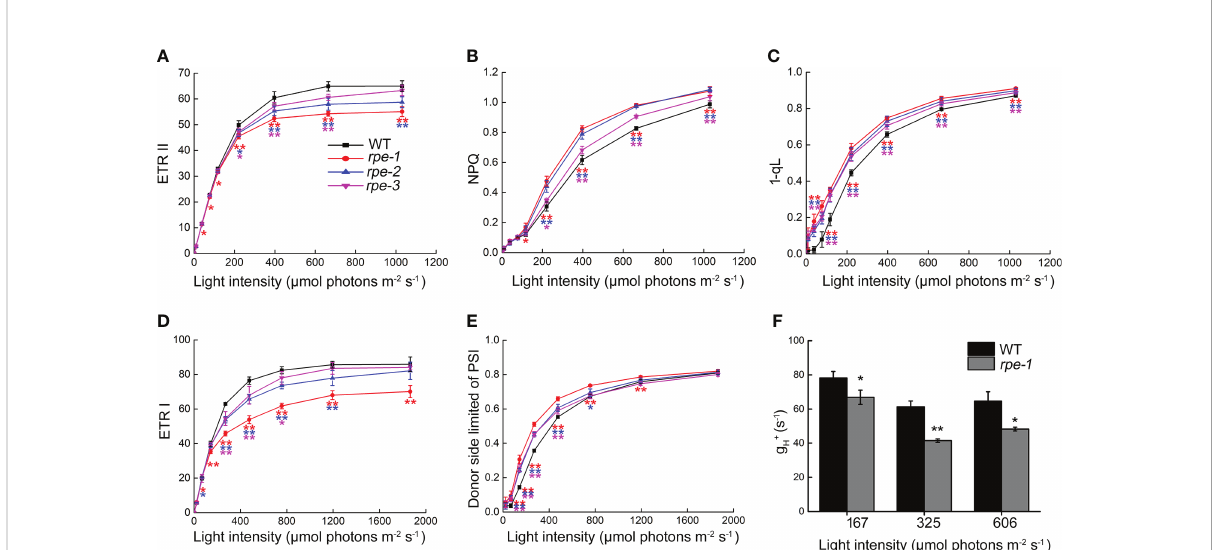
FIGURE 6 Analysis of light intensity dependence of photosynthetic parameters of WT and the rpe mutants. (A) Electron transport rate around PSII (ETR II). (B) Nonphotochemical quenching (NPQ). (C) 1-qL of PSII. qL means the fraction of open PSII centers, and 1-qL re fl ects the PQ redox state of PSII. (D) Electron transport rate around PSI (ETR I). (E) Donor-side limited PSI (with donor-side oxidized). (F) Analysis of ATP synthase activity in WT and rpe-1 . Values are means ± SD (n=3-6).Signi fi cant differences between WT and the rpe mutants are indicated by asterisk according to the Student ’ s t test (*P < 0.05; **P < 0.01), The red, blue, and pink asterisk represents signi fi cant differences between WT and rpe-1, rpe-2 , rpe- 3 ,